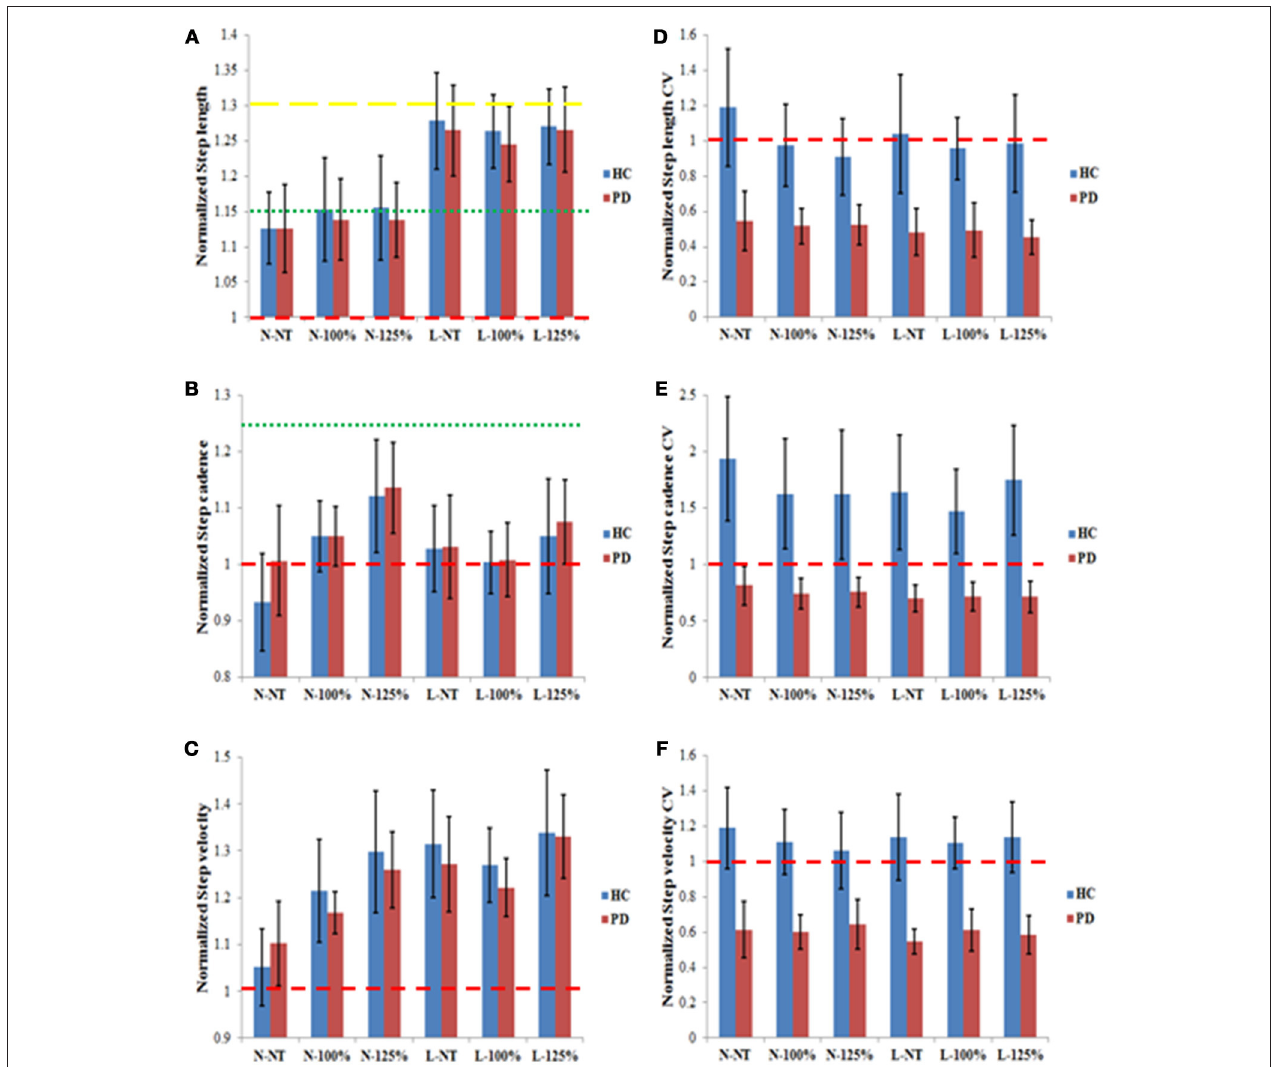
FIGURE 3 | Normalized results for step length (A) , step cadence (B) , step velocity (C) , step length CV (D) , step cadence CV (E) , and step velocity CV (F) for the PD and the HC groups in the six different experimental conditions. The results are presented as normalized results calculated as the values obtained divided by the corresponding individual baseline values. Values > 1 indicate an increase relative to baseline; values < 1 indicate a decrease relative to baseline. The red dashed lines in all graphs represent the value that would indicate no difference from baseline measures (1). In (A) the green and yellow dashed lines represent the step length prescribed in the N and L conditions, respectively. In (B) the dashed red and the green lines represent the step cadence prescribed in the 100 and 125% conditions, respectively. The error bars represent the confidence intervals (95%) of the